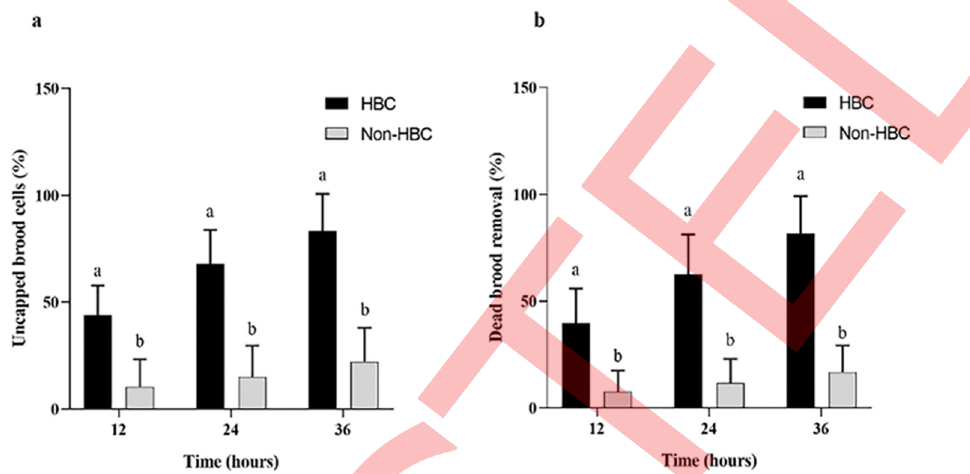
Fig 1. The uncapping and removal percentage of dead brood between hygienic and non-hygienic bee line over time of inspection. (a) the uncapping percentage of brood cells between both bee stocks after, 12, 24, and 36 h, respectively. (b) the removal percentage of dead broods between both bee stocks after, 12, 24, and 36 h, respectively.